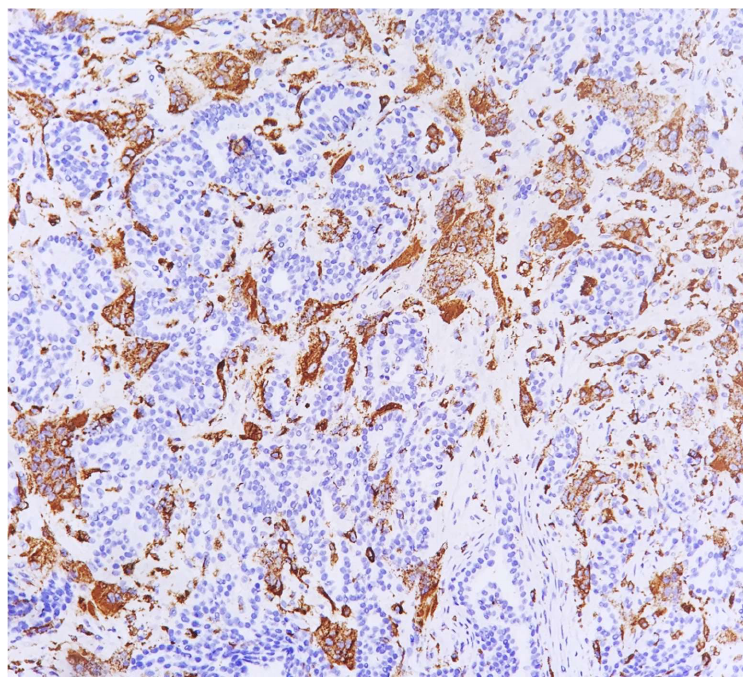
Figure 6. Immunohistochemical reaction for CD68 in presurgical biopsy showing positive macrophages and numerous stromal osteoclast-like giant cells, intermingled with CD68-negative neoplastic cells (200× ).